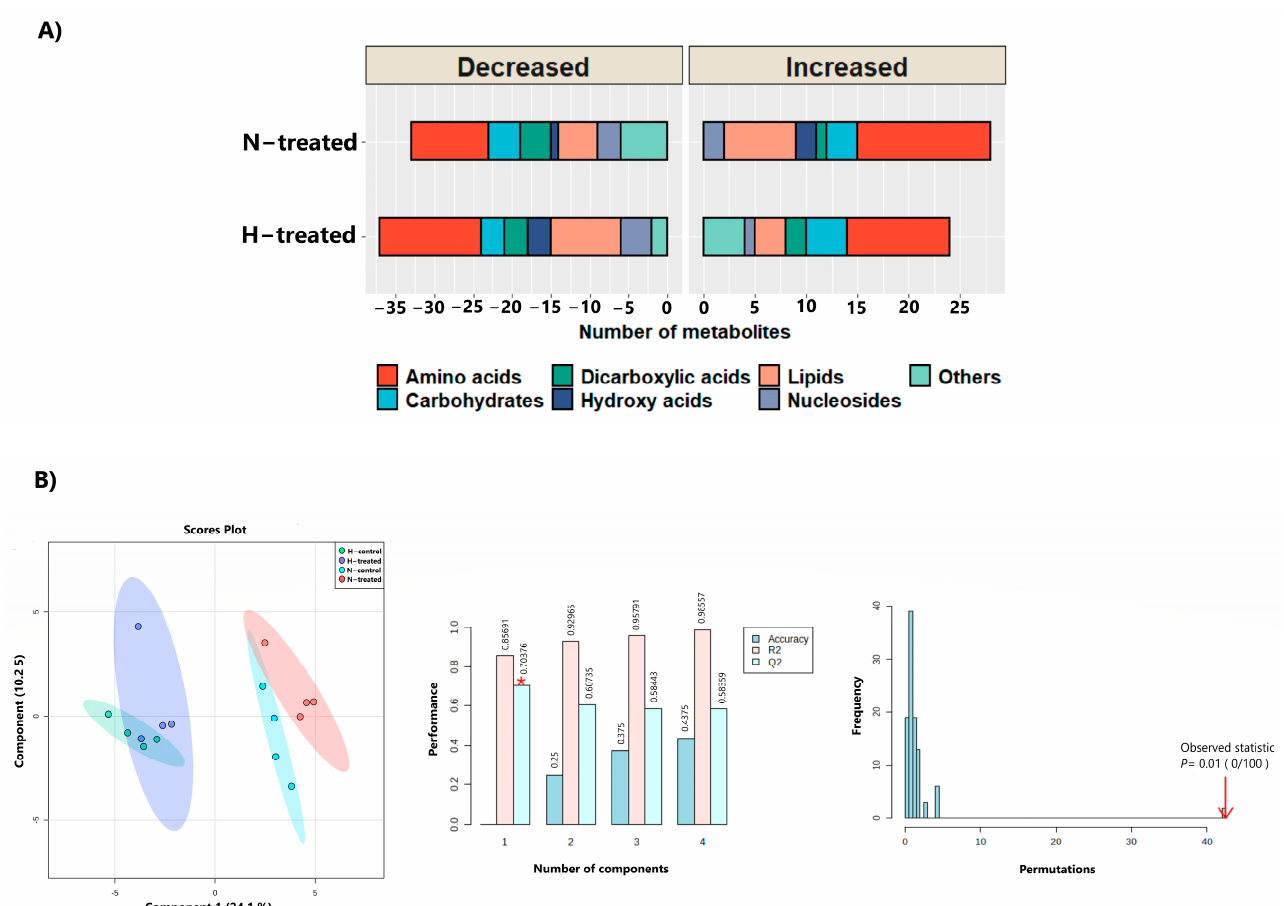
Figure 1. ( A ) Numbers of up- and downregulated metabolites following treatment with PEDF (100 nM, 24 h). ( B ) PLS-DA plot of MDA-MB231 cells under glycaemic loading with and without PEDF created with 95% confidence and cross-validated R2X, R2Y, and Q2 coefficients (middle). The red asterisk implies the best classifier. The histogram showing the permutation test with a permutation number n = 100, which showed that the model was significant. Key: H, high glucose; N, normal glucose .